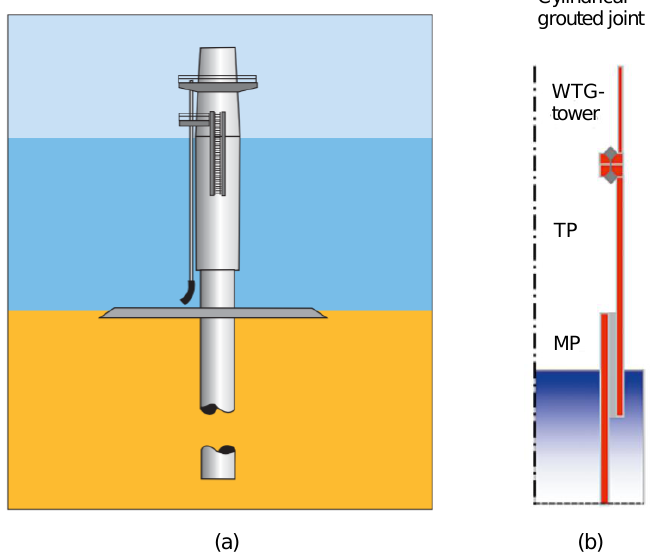
Figure 4. ( a ) Components of a monopile foundation, and ( b ) schematic of a grouted connection (adapted from [7,9] with permission from DNV GL-Energy, 2016 ( right ). Copyright Wiley-VCH Verlag GmbH & Co. KGaA ( left ) 2014).